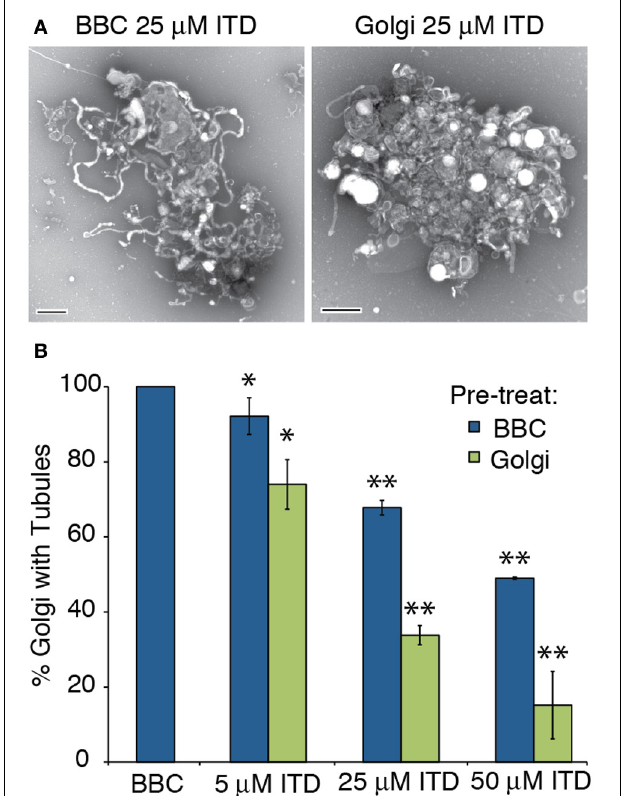
FIGURE 2 | ITD inhibits Golgi-membrane associated proteins. Various concentrations of ITD were either pre-incubated at 37 ◦ C for 15min with BBC or Golgi membranes before combining the cytosol and Golgi, followed by further incubation at 37 ◦ C for 15min. ( A ) Representative negative stain Golgi treated with ITD, which was pre-incubated as labeled. Scale bars = 500nm. ( B ) Quantification of the percent of Golgi with membrane tubules, normalized to BBC alone (1.5mg/ml). ITD concentrations shown are the final concentration after mixing the Golgi and cytosol. Error bars = s.e.m. Differences between samples with ITD pre-treated BBC or Golgi were statistically different, with p -values < 0.04 ( ∗ ) or 0.006 ( ∗∗ ), determined using a two-tailed t -test for each ITD concentration.